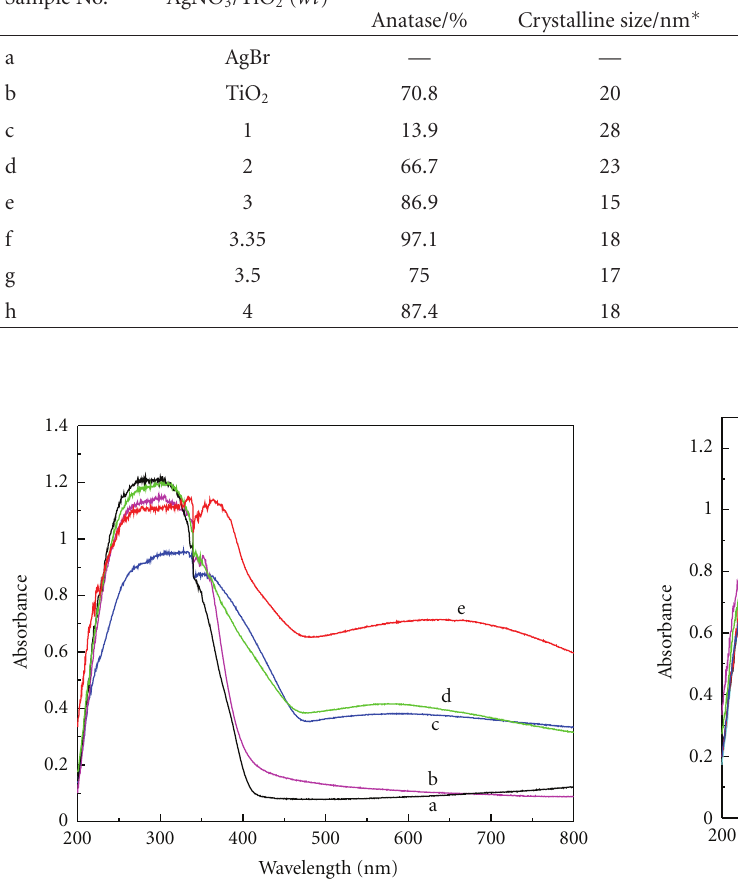
Figure 4: UV-vis spectra of AgBr/TiO 2 with di ff erent mass ratios of /m m AgNO 3 TiO 2 (a) 1; (b) 2; (c) 3; (d) 3.35; (e) 3.5; (f)